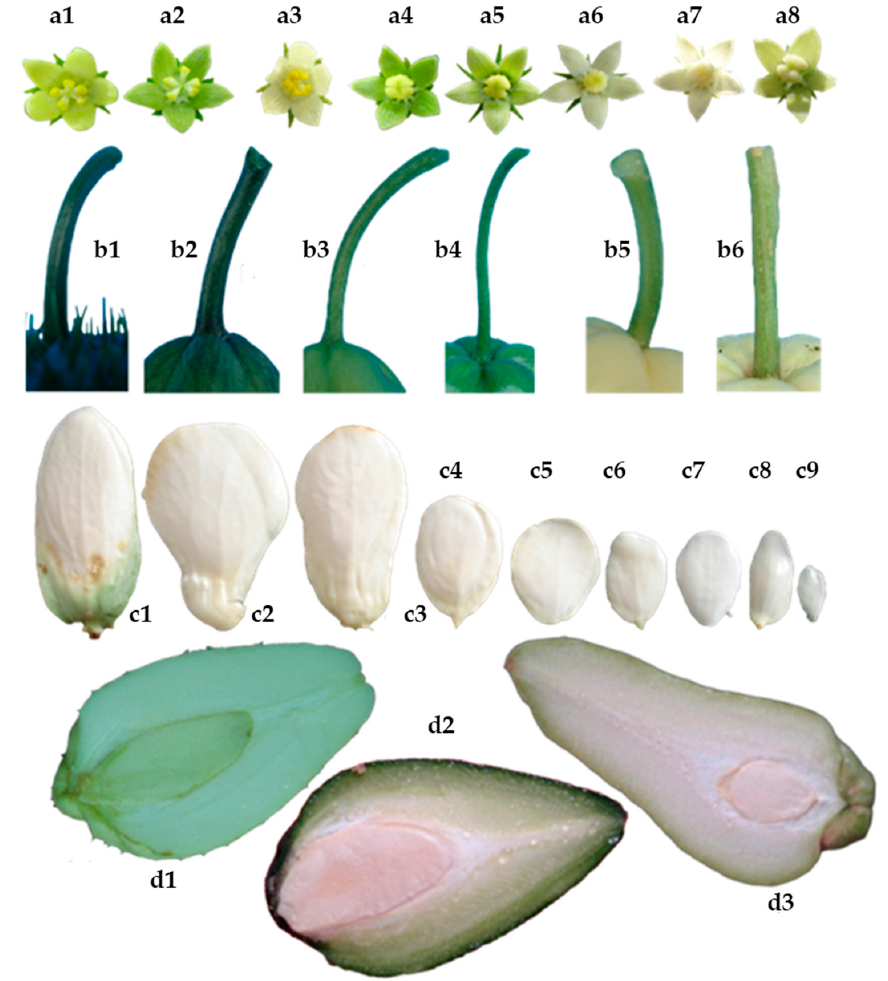
Figure 3. Quantitative and qualitative morphological features of biological variants that allow varietal distinction of Sechium edule : ( a1 – a3 ) staminate flowers, ( a4 – a8 ) pistillate flowers, ( b1 – b6 ), color, shape, thickness, and length of fruit peduncle, ( c1 – c9 ) shape, color, ornamentation, and seed length, ( d1 – d3 ) color and mesocarp thickness.